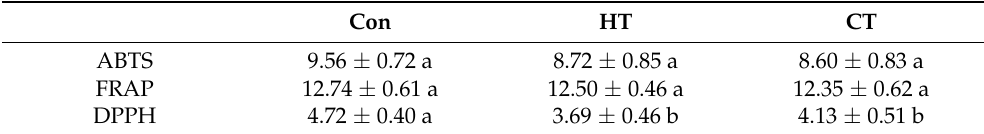
Values represent mean ± standard deviation of three biological and three technical replicates (N = 9). Different letters indicate a significant difference among the values in a row (ANOVA, Duncan test, p ≤ 0.05). Con = plants watered with room-temperature water, HT = plants watered with high-temperature water, CT = plants watered with cold water.